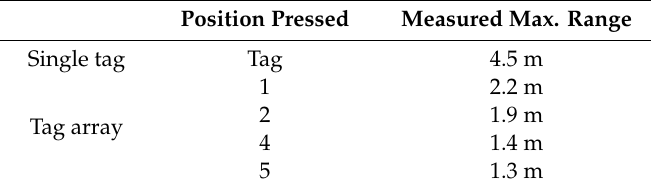
Figure 13. ( a ) Photographs of the finished prototype of the proposed tag array; ( b ) schematic and ( c ) photograph of the measurement of the proposed tag array. Table 4. The measured maximum reading ranges of the proposed single tag and tags in the